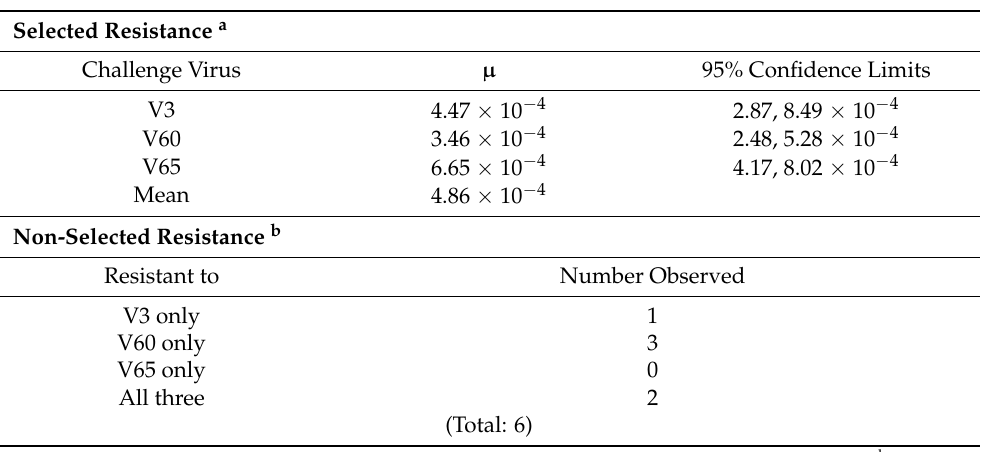
Table 4. Rates of Resistant Cell